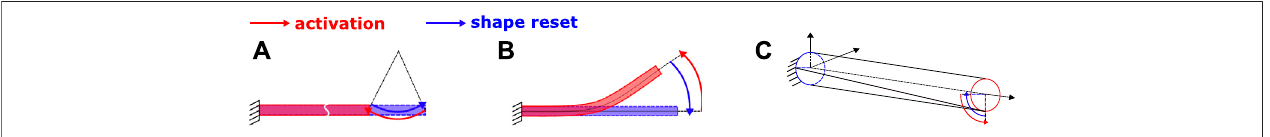
FIGURE 4 | Examples of elementary SMA for uni-directional rotational motion: (A) Normal-motion-driven SMA element; (B) Bending-motion-driven SMA element; (C) Torsional-motion-driven SMA